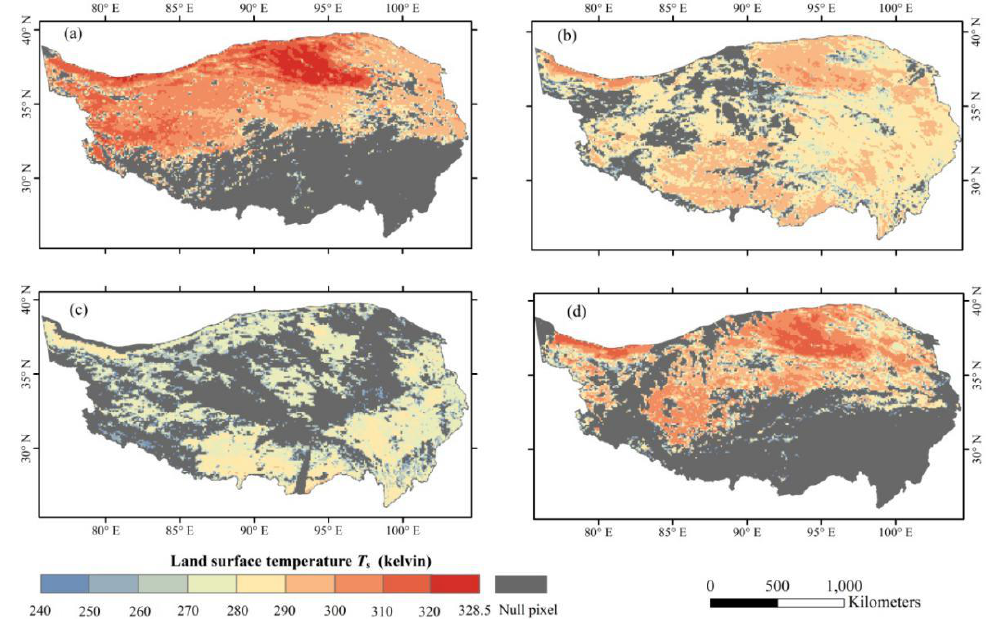
Figure 5. Spatial distribution of land surface temperature T s at 10:30 local time on July 24 ( a ) and October 25 ( b ) in 2014, and January 21 ( c ) and April 26 ( d ) in 2015. Note: T s stands for land surface temperature. The unit is kelvin.